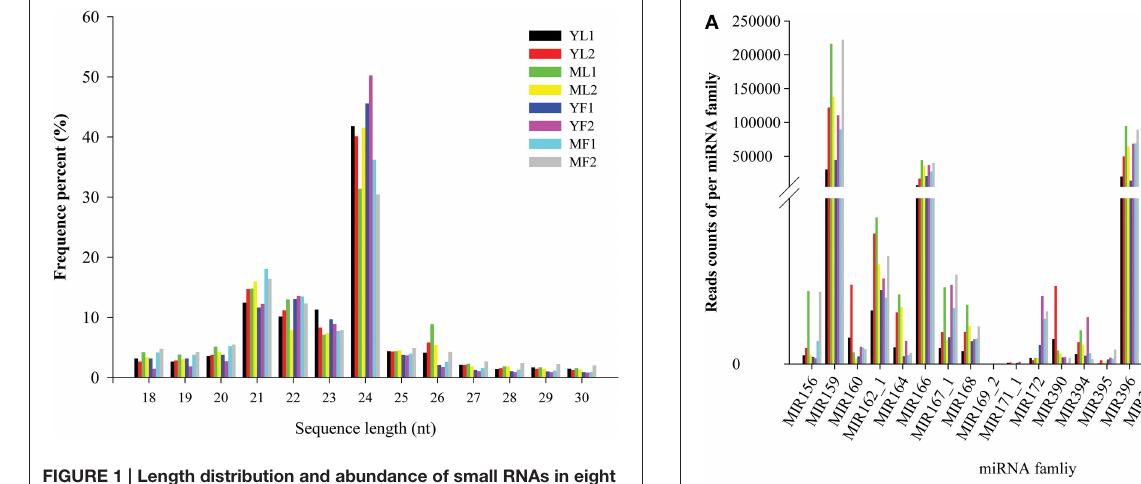
FIGURE 1 | Length distribution and abundance of small RNAs in eight libraries of Eucommia ulmoides. X-axis, length of sRNA distribution; Y-axis, corresponding percentage of raw reads.